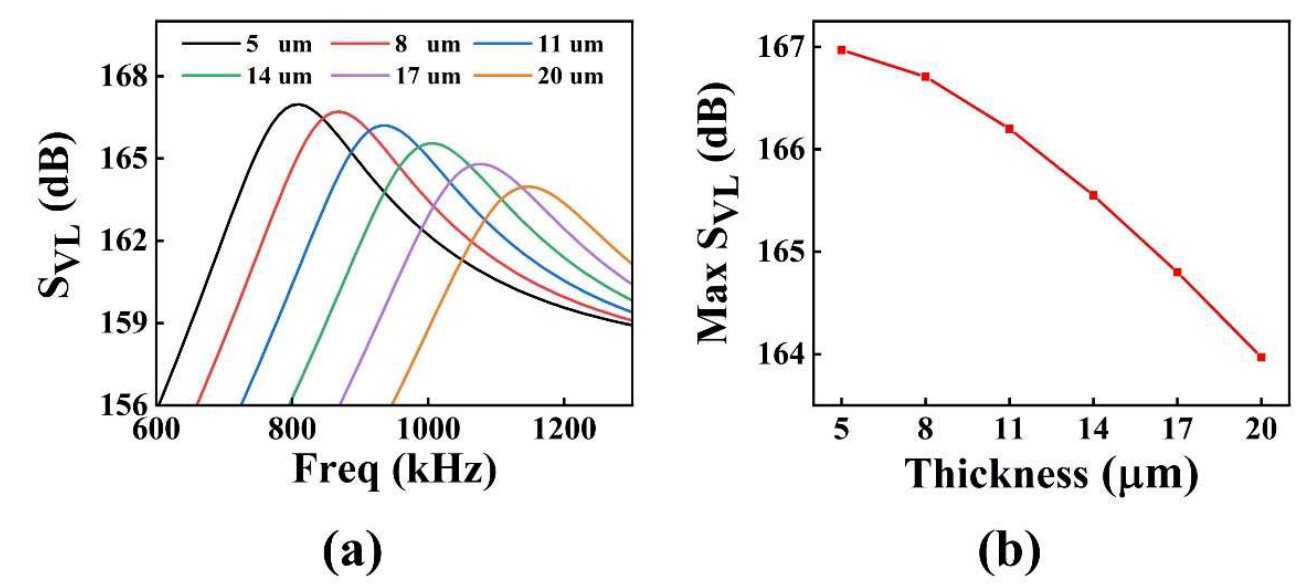
Figure 5. The pMUT with I-shaped diaphragm: ( a ) transmitter voltage response curve graph;